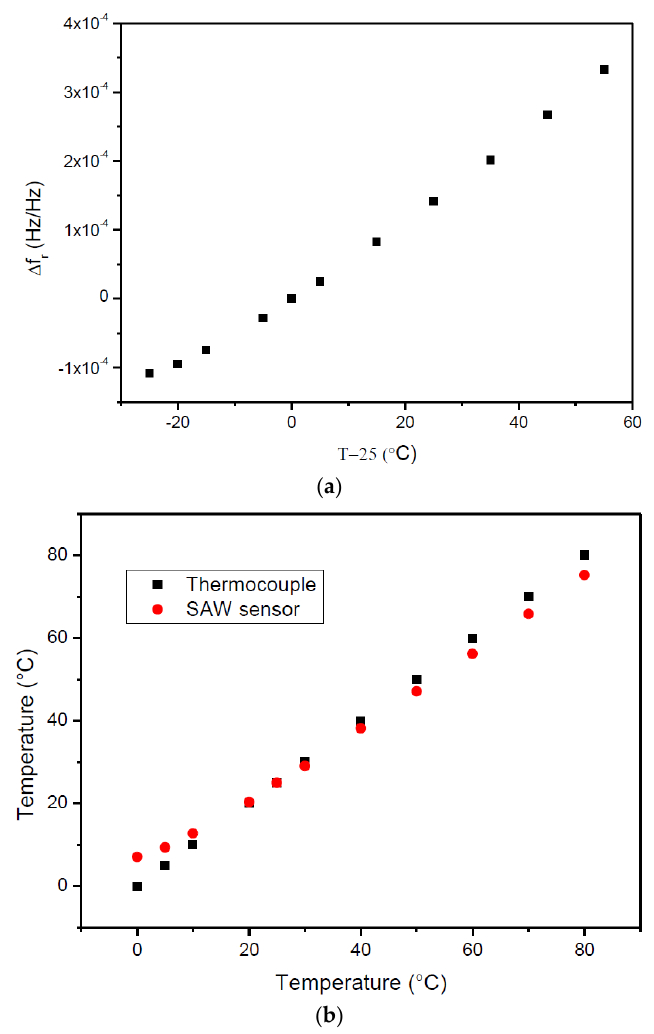
Figure 7. ( a ) ∆𝑓 𝑟 obtained for different ∆𝑇 . Two dipole antennas were connected directly to the sensor and interrogation unit, respectively. ( b ) Temperature obtained by the thermocouple (black squares) and SAW sensor (red circles).